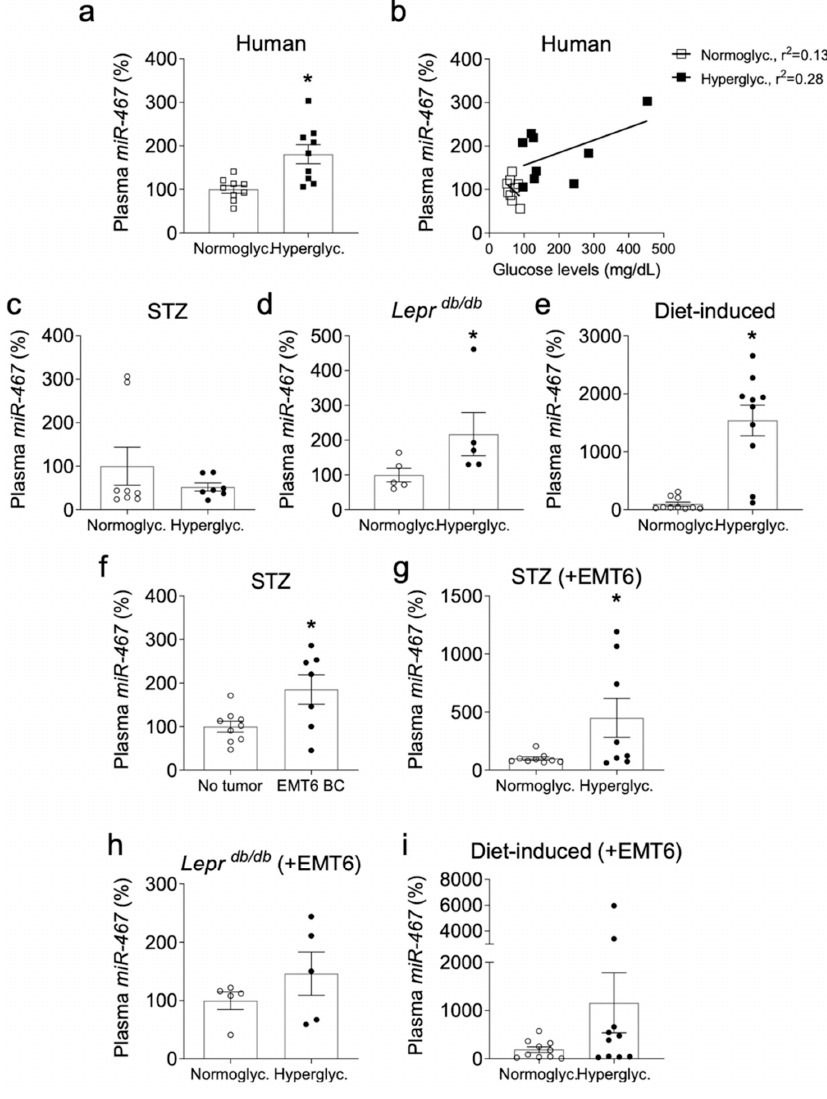
Figure 5. Circulating miR-467 is detected in hyperglycemic patients and mice. ( a ). Plasma from hyperglycemic and normoglycemic patients was acquired from the CCF Biorepository. Plasma miRNA was extracted and miR-467 was quantified by RT-qPCR ( n = 10/group). ( b ). Correlation between blood glucose levels and miR-467 in plasma. ( c – e ). Plasma from hyperglycemic mice was collected from ( c ). STZ-treated, ( d ). Lepr db/db mice, and ( e ). mice on Western diet, with corresponding normoglycemic controls. ( f ). Plasma from hyperglycemic STZ-treated mice was collected to compare miR-467 levels in mice with tumors (injected with BC cells EMT6) and control animals without tumors. ( g – i ): Plasma was collected from mice with tumors to determine if circulating miR-467